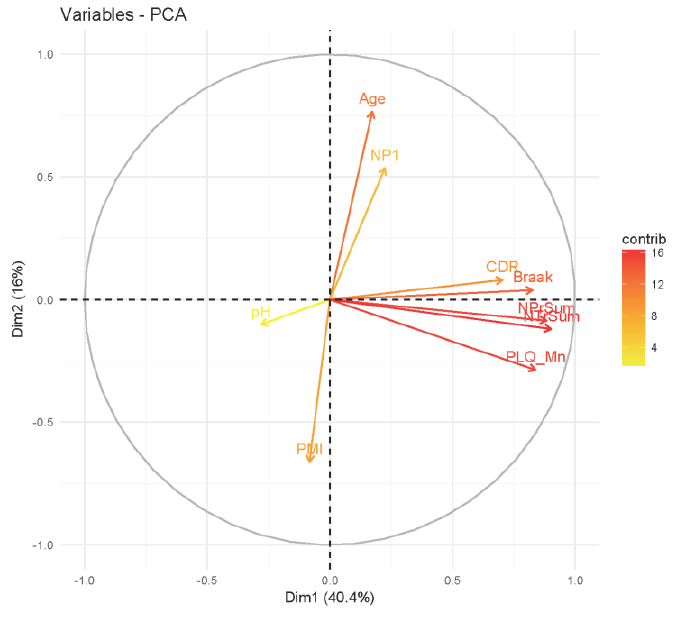
Figure 3. Variables factor map of the 1st and 2nd PCs of clinical neuropathological metrics for all individuals in the MSBB Tissue Array Panel study.